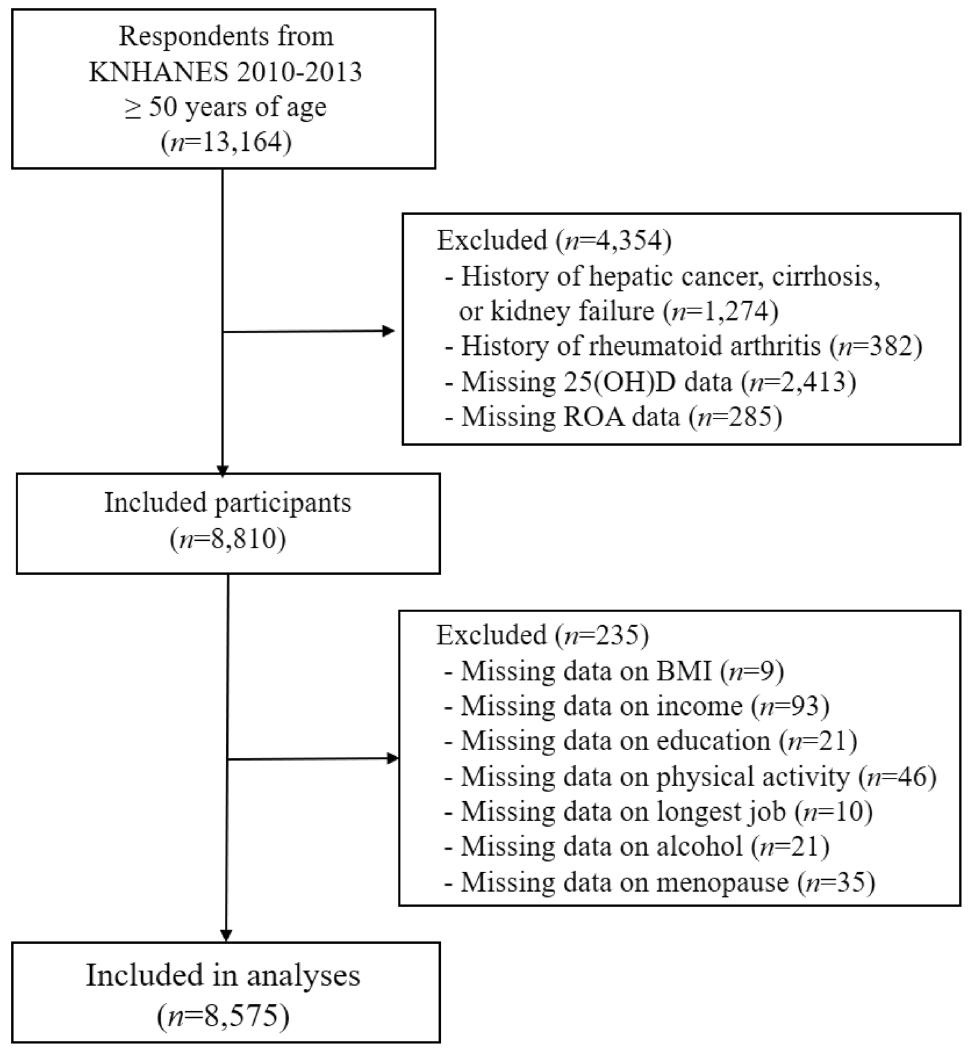
Figure 2. Flow diagram of participants included in the analyses. BMI, body mass index; KNHANES, Korea National Health and Nutrition Examination Survey; ROA, radiologic osteoarthritis; 25(OH)D, 25-hydroxyvitamin